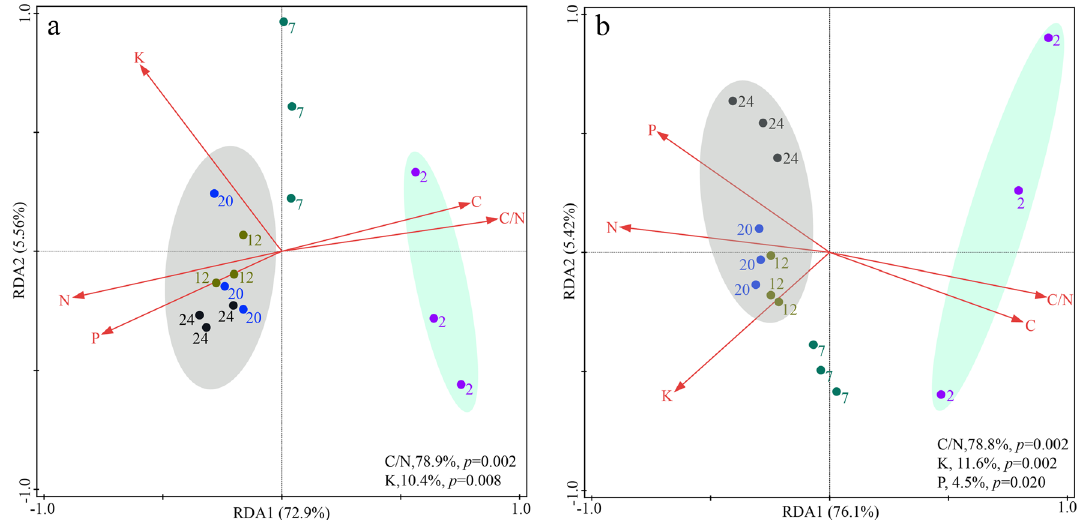
Figure 4. Redundancy analysis of straw bacterial community composition at phylum ( a ) and class ( b ) levels.